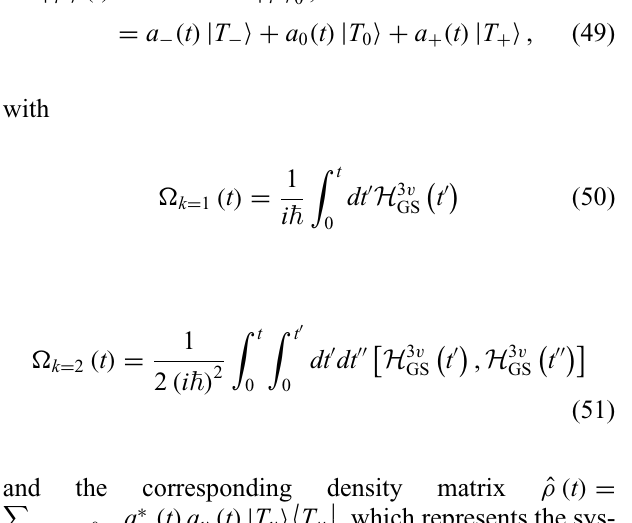
FIG. 8. (a) Spin dephasing leading to decoherence due to the fluctuating electric charges. (b) Comparison between single- exponential and biexponential decoherence processes. (c) Deco- herence contributions in Eq. (66) as a function of diode voltage. (d) Increase of T 2 ± decoherence time as a function of voltage due to the reduction of the electric noise. The dark blue curve is plot- and d ⊥ ( τ I ) dipole values by a factor of ted exaggerating the d (cid:3) G G approximately 10 (100). In (c),(d) the solid (dashed) lines rep- √ + d (cid:3) 2 d ⊥ resent the contributions within T 2 ± proportional to √ G G − d (cid:3) ( 2 d ⊥ G G